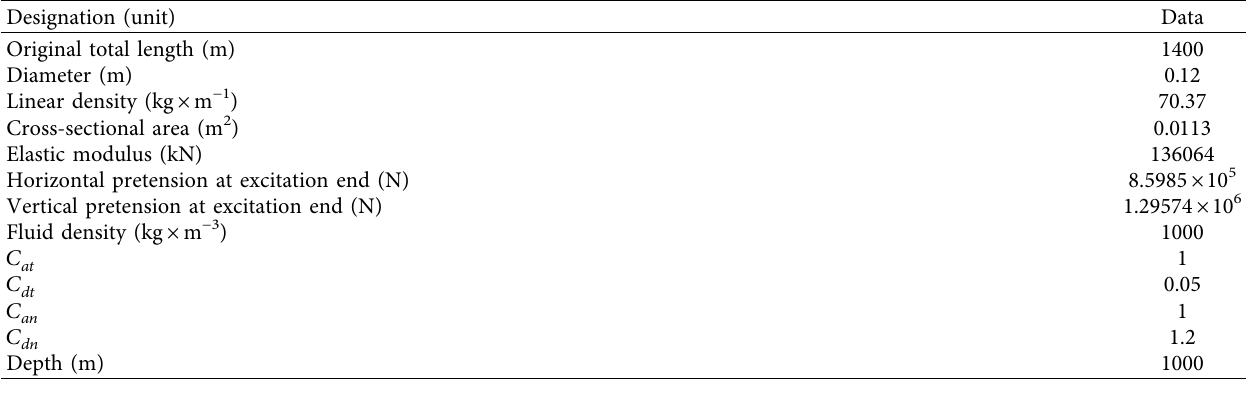
Table 1: Structural parameters of mooring line